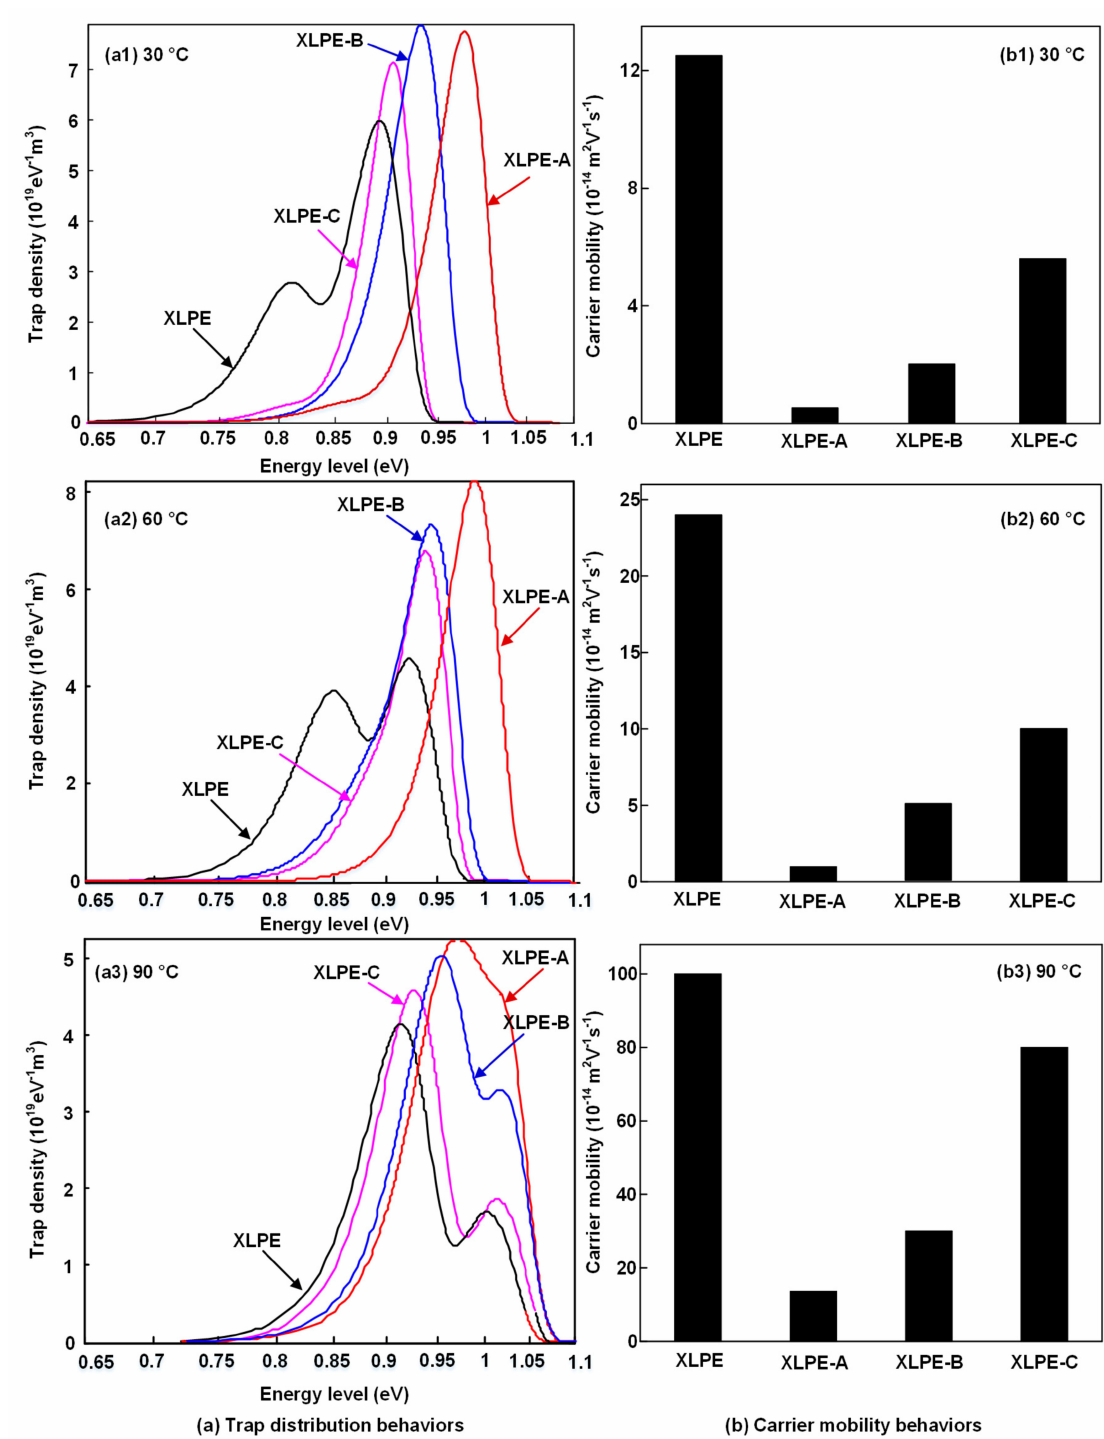
Figure 6. Trap distribution and carrier mobility behaviors of XLPE and its polycyclic compounds